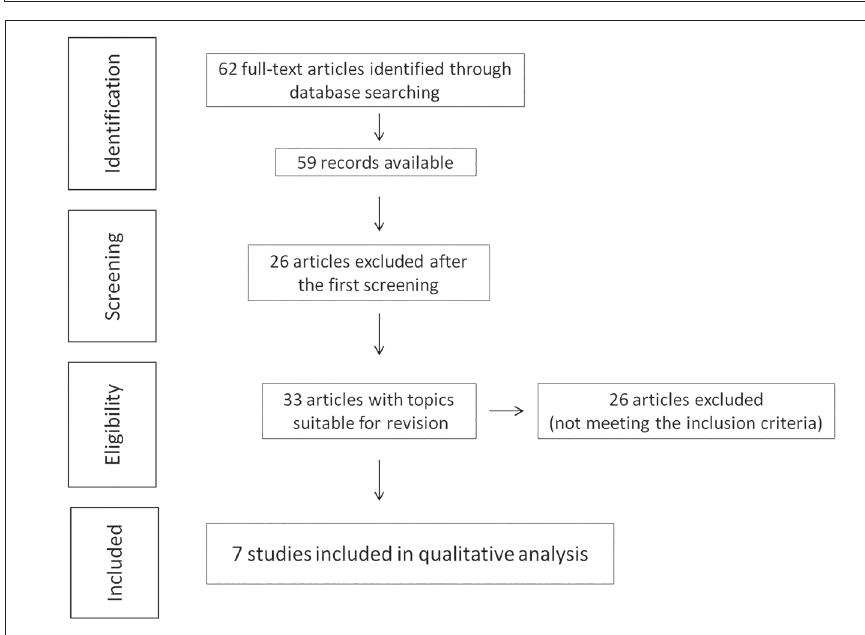
Figure 1. The studies selection process produced 62 full-text articles, of which 59 are